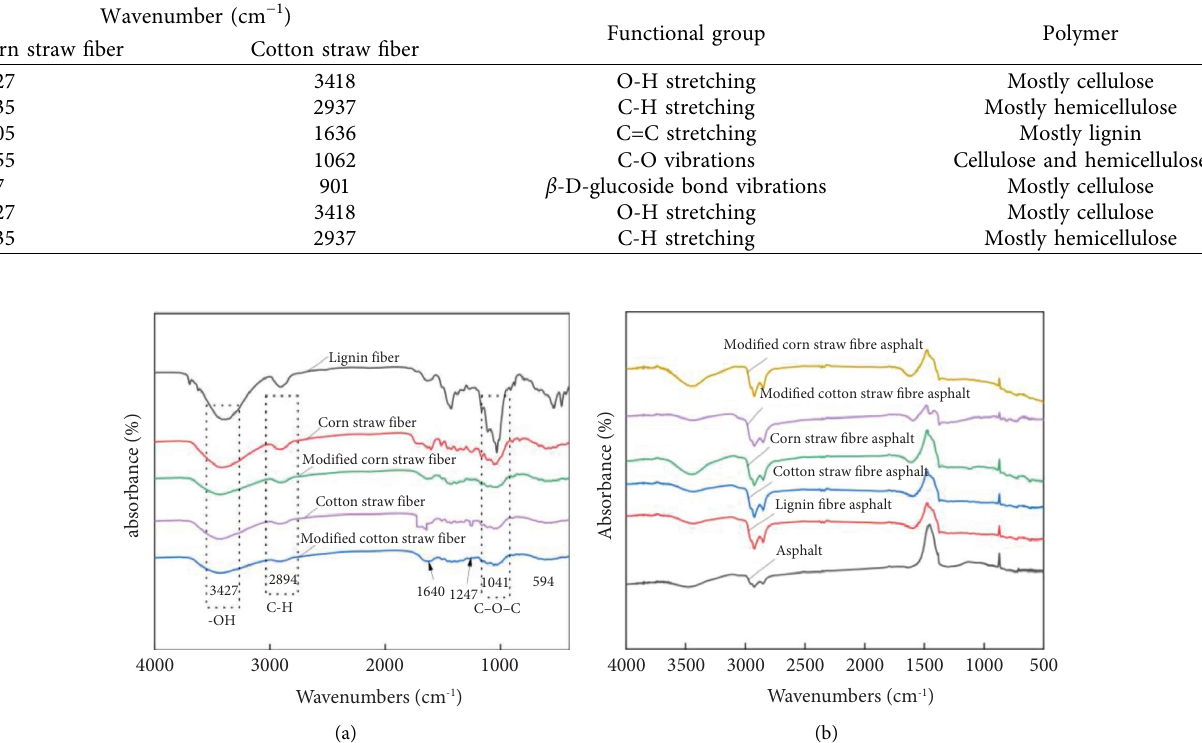
Figure 15: Comparative infrared spectra of (a) straw fber and (b) asphalt